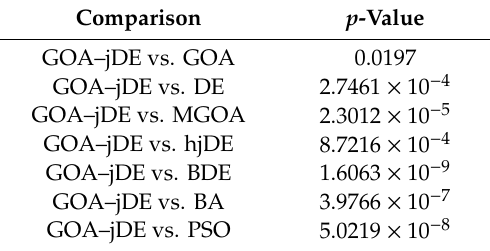
Table 8. The p -value (Wilcoxon rank sum test) for the experimental results of the MCE method. Comparison p -Value